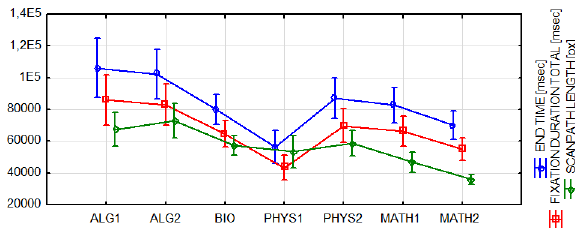
Figure 9. A comparison of the selected eye-tracking parameters for the particular tasks. ment that the task-solving time and the derived eye- tracking parameters are indicators of the task difficulty evaluation of the task difficulty level provided by the